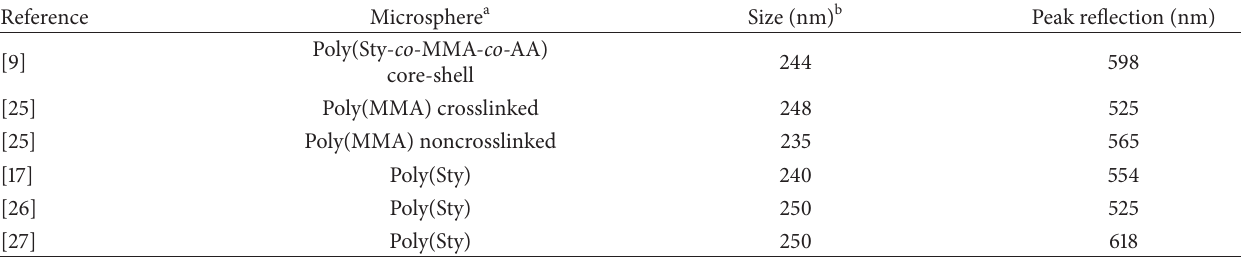
Table 4: Reflection peak position from photonic films made from polymeric microspheres having similar sizes reported in the literature.